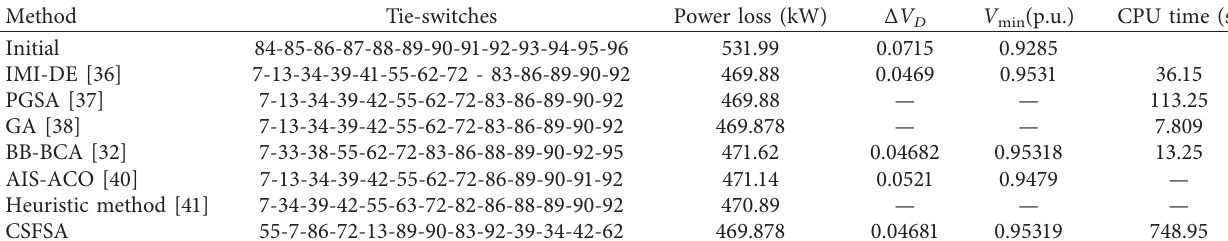
Figure 5: Single-line diagram of the 84-bus test system. Table 3: Result comparison of CSFSA with other methods for the 84-bus system.